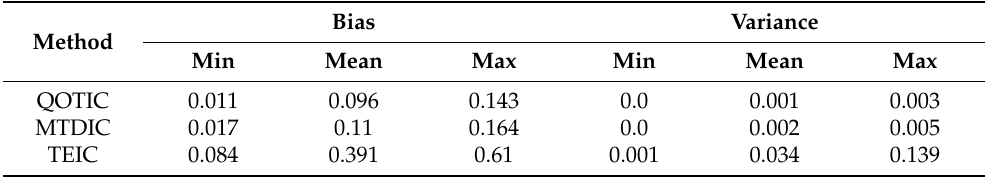
Table 2. The analysis of bias and variance of QOTIC, MTDIC,